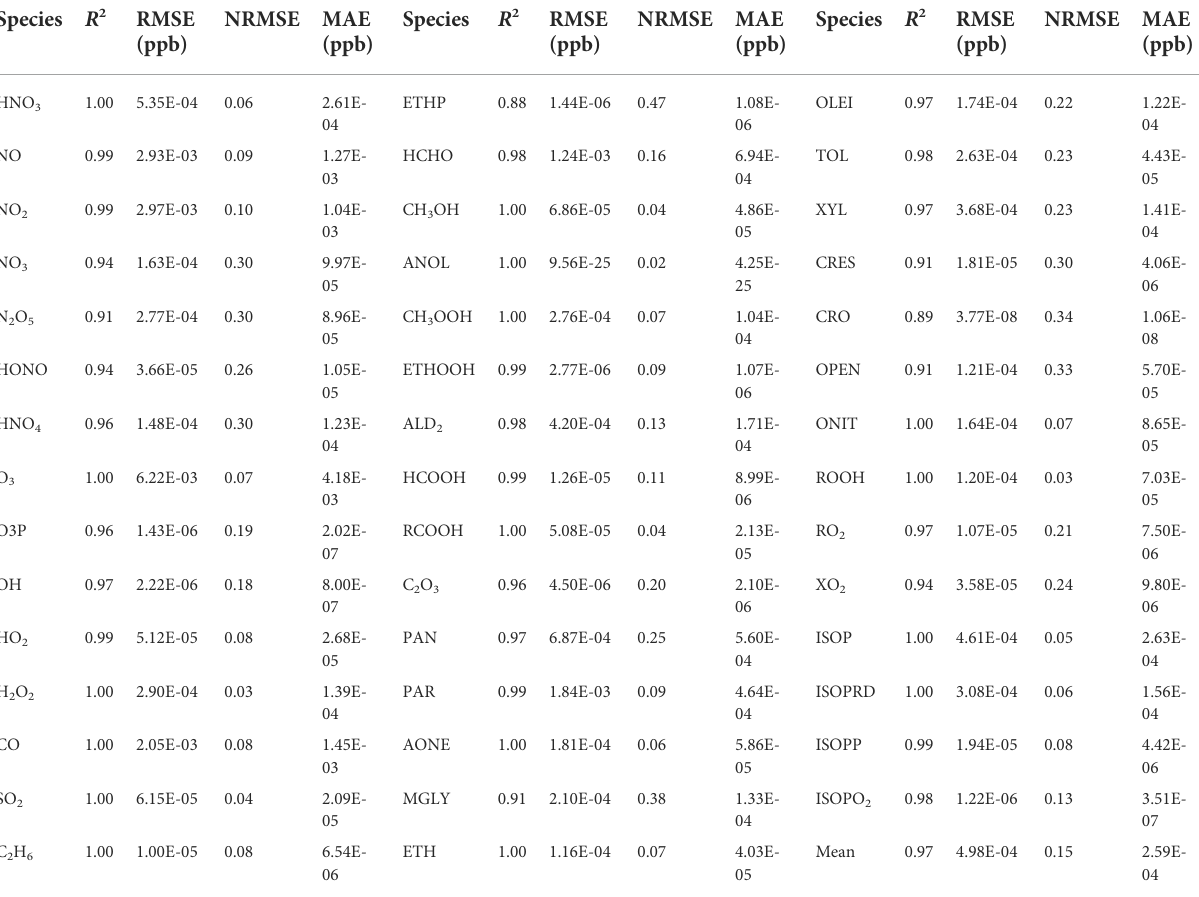
TABLE 1 Statistical index of the 20-min concentration changes of 47 species predicted by CBM-Z module of GNAQPMS and neural network (NN) emulator. Species R 2 RMSE